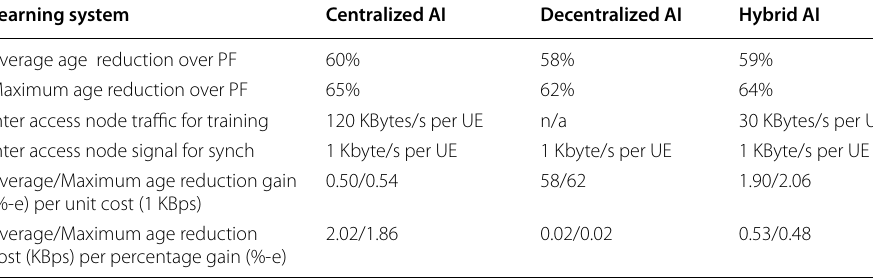
neural network model for access node m with the hybrid AI architecture is denoted H S H A H : S H → A H by (cid:31) m m m , where m and m correspond to the state vector and the action set of access node m , respectively.